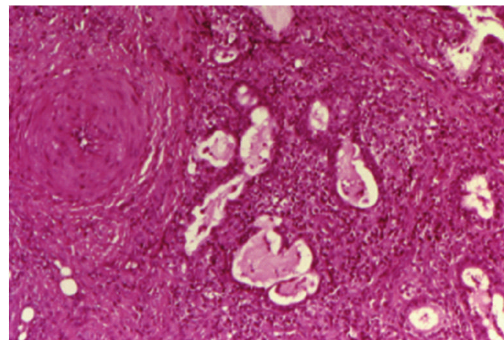
Figure 3: In the fibrous connective tissue were found, squamous metaplasia of the salivary ducts and acinar necrosis with preserva- tion of the lobular architecture of the neighbouring minor salivary glands.